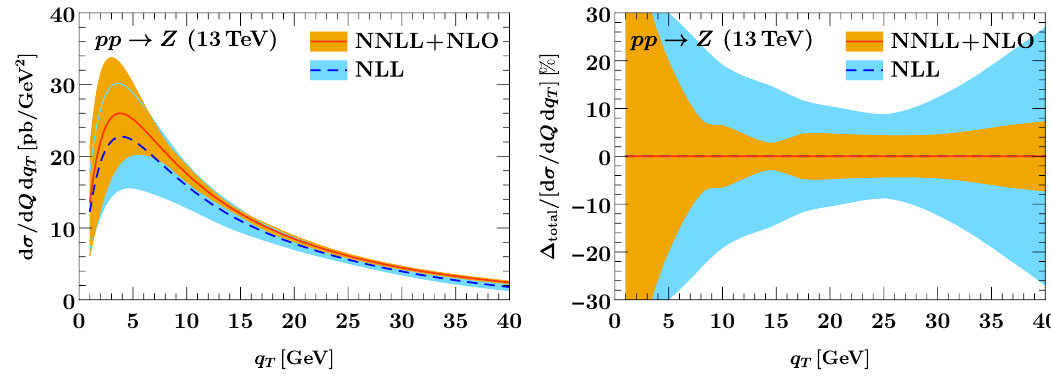
Figure 5 . The single-di(cid:11)erential q T spectrum at NLL (blue) and NNLL+NLO (orange), using the q T resummation method described in the text. The bands indicate (cid:1) II (cid:8) (cid:1) FO . In the right panel, the uncertainties are shown as percent di(cid:11)erences relative to the central result at each order. p 2.4 SCET : T (cid:28) q (cid:28) Q + T